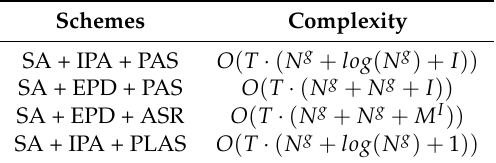
Table 3. Complexity of different combination schemes of solution